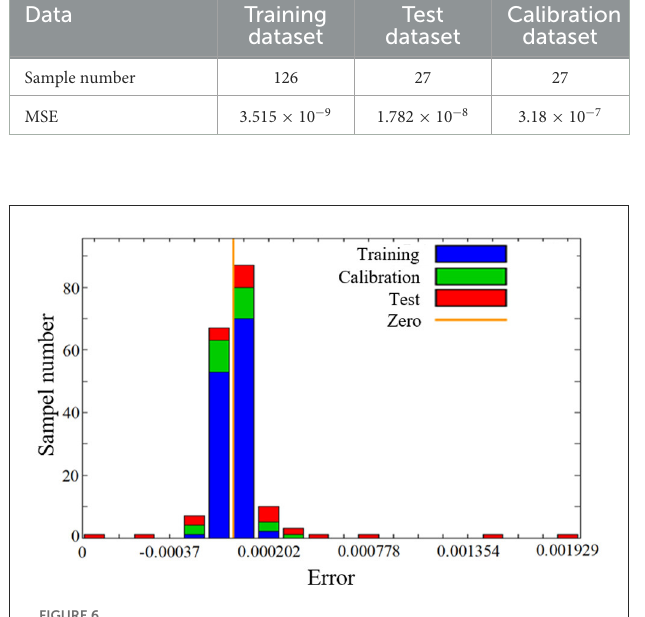
FIGURE6 Error and sample distribution of the neural network.